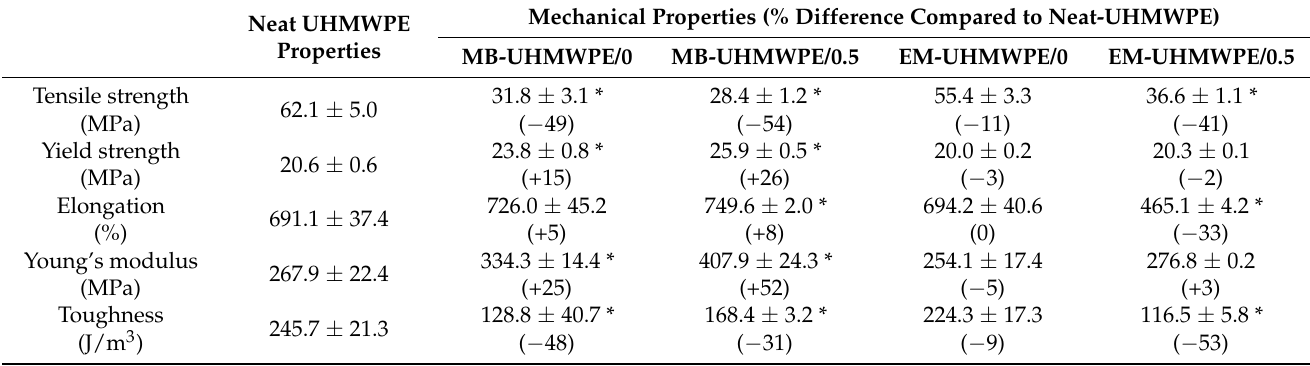
Table 2. Effect of blending process and CNF addition on the mechanical properties of UHMWPE.